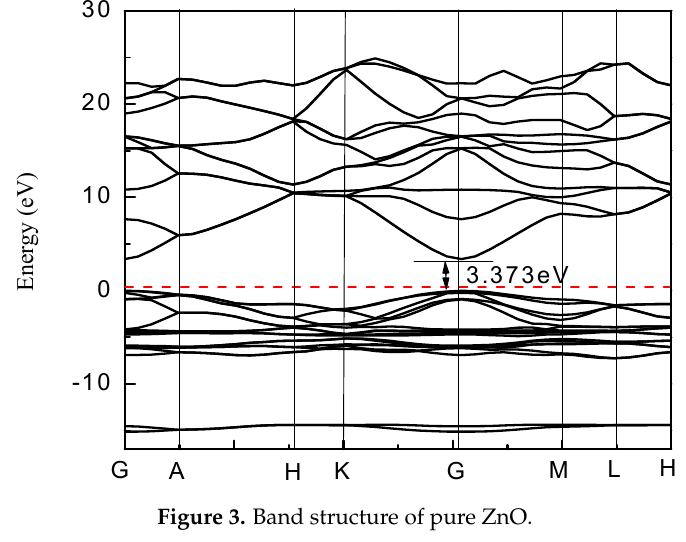
Figure 3. Band structure of pure ZnO.